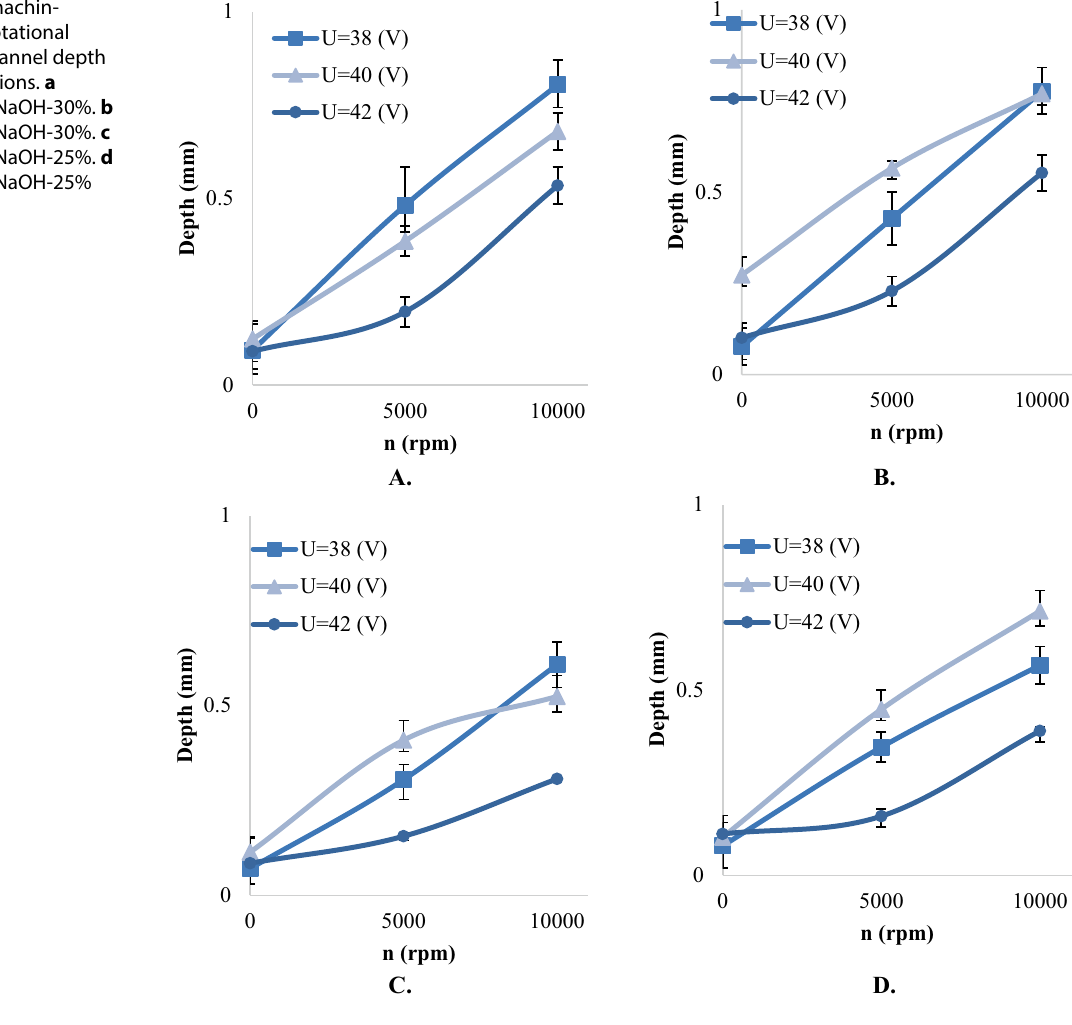
Fig. 12 Effect of machin- ing voltage and rotational speed on microchannel depth in different conditions. a V = 1.2 mm/min - NaOH-30%. b V = 0.6 mm/min - NaOH-30%. c V = 1.2 mm/min - NaOH-25%. d V = 0.6 mm/min -